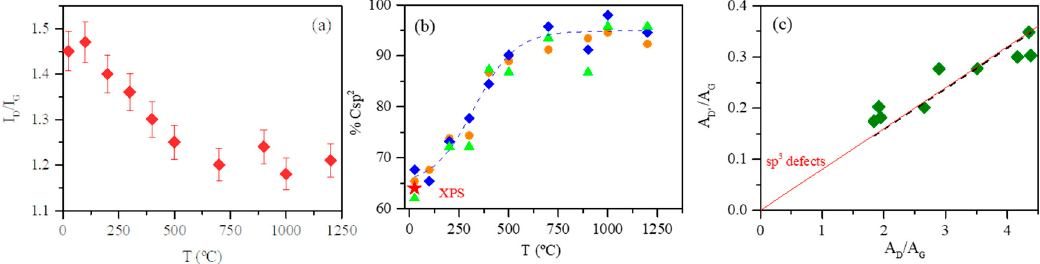
Figure 4. ( a ) Variation of the I D / I G ratio with temperature for graphene oxides in heterostructures and annealed at between 25 and 1200 °C. ( b ) Variation of the percentage of C sp 2 with temperature calculated from the following correlations: I D / I G ratio (circles), frequency of 2D band (diamonds) and the frequency of the combination band (triangles). Scatter graphs represent experimental data and the dotted line is just a visual guide. ( c ) Variation of the relative integrated area of the D ′ band with the relative integrated area of the D band for graphene oxides in heterostructures annealed at di ff erent temperatures. Dotted line is the linear fit of the experimental data and the solid line is calculated according to the theoretical model for sp 3